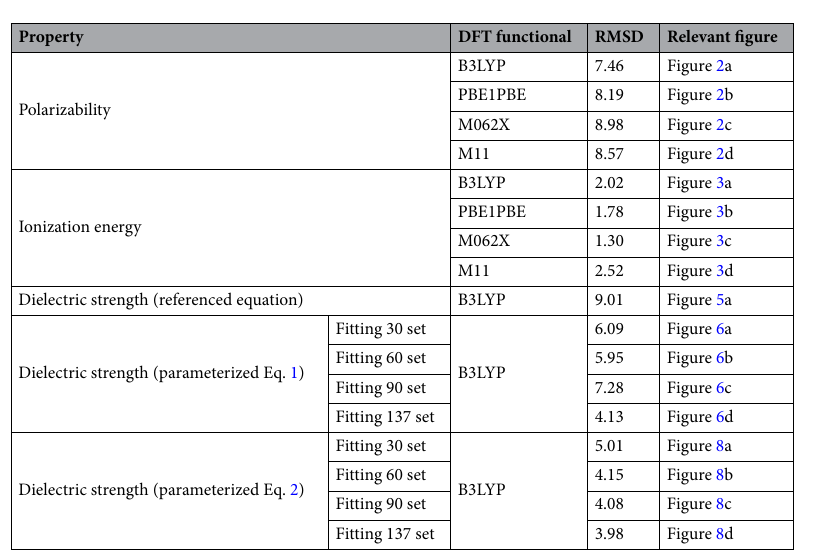
Table 1. Root-mean-square deviation (RMSD). RMSD values for polarizability, ionization energy, and dielectric strengths with referenced/parameterized equations.